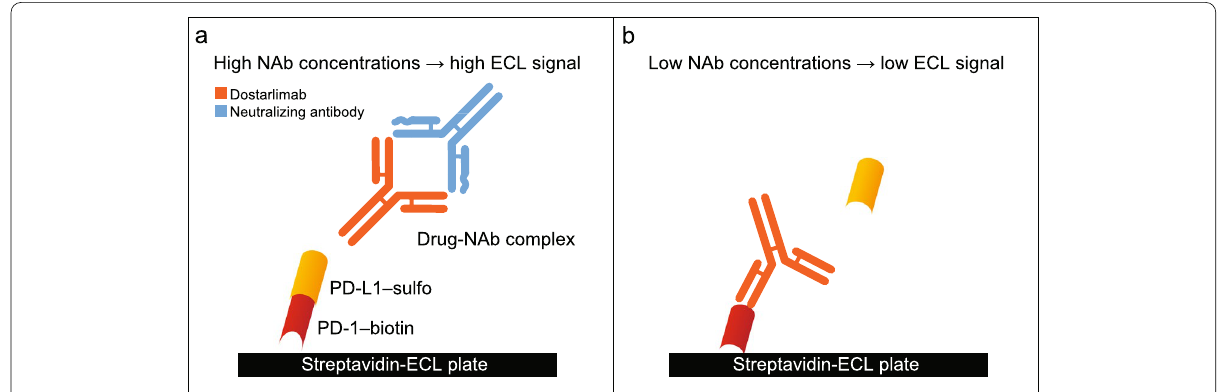
Fig. 1 NAb detection assay. A Complexes form between the fixed amount of added drug and NAb; the formation of these complexes allows SULFO-TAG–labeled PD-L1 to bind to biotinylated PD-1, which can bind to the streptavidin-ECL plate. B In the absence of NAb, the fixed amount of drug added to the solution binds to biotinylated PD-1 and prevents its interaction with PD-L1. SULFO-TAG–labeled PD-L1 bound to PD-1 is necessary to generate the ECL signal. ECL, electrochemiluminescence; NAb, neutralizing antibody; PD-1, programmed death 1; PD-L1, programmed